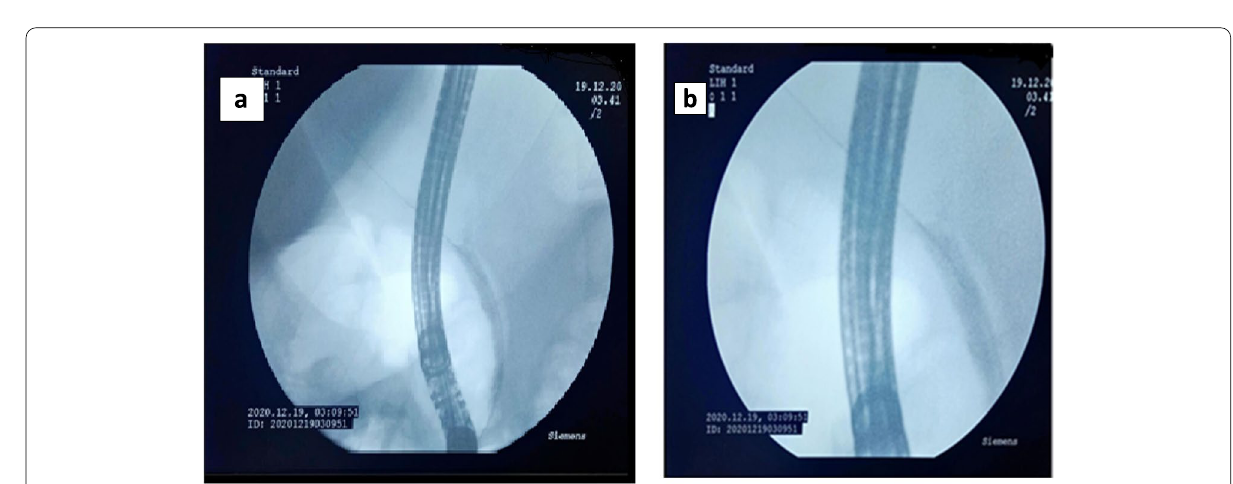
Fig. 2 a Limited papillotomy was done followed by Initial inflated balloon. b The inflated balloon within the CBD